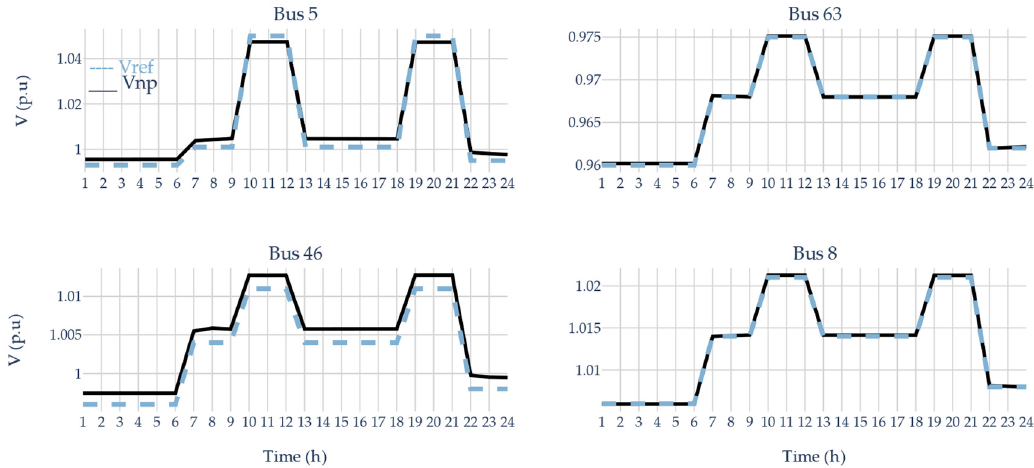
Figure 7. Voltage profiles of pilot nodes (5, 63, 46, and 8) for the IEEE 118-bus test system.